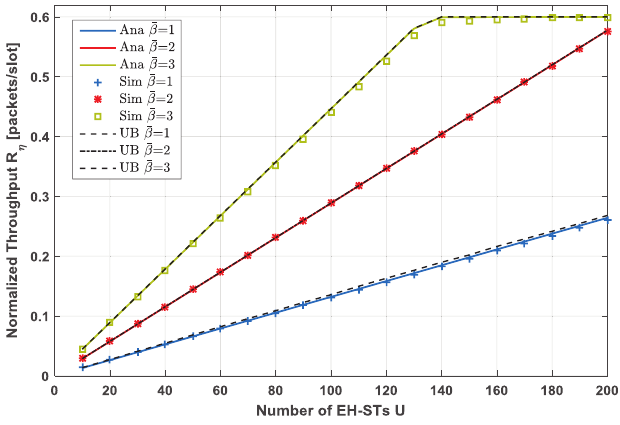
Figure 4. Normalized network throughput for different network sizes, under different EH rates ¯ β ∈ { 1,2,3 } , e max = 10. For random access (RA) schemes, number of time slots in each frame N = 200, QPSK modulation, E s / N 0 =